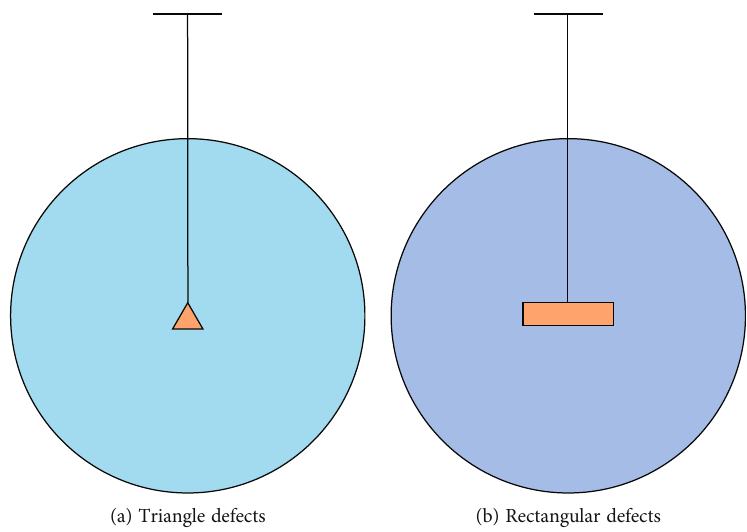
Figure 8: Model diagram of polygon defect simulation.